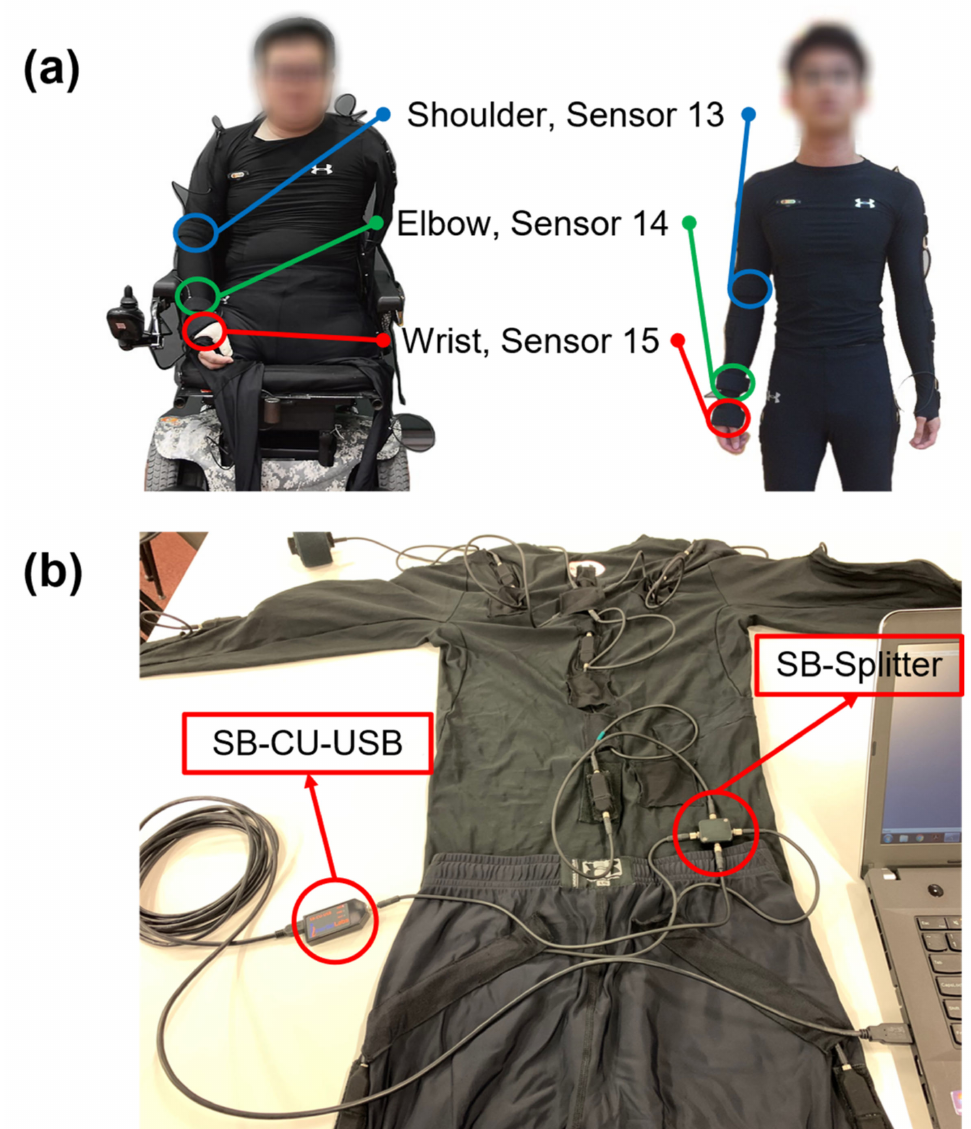
Figure 1. ( a ) The 3DSuit inertial motion capture system with the shoulder, elbow, and wrist sensors on wheelchair ( left ) and able-bodied ( right ; AB) table tennis players; ( b ) SB-Splitter and SB-CU-USB configuration for connecting the long sleeve compression shirt and